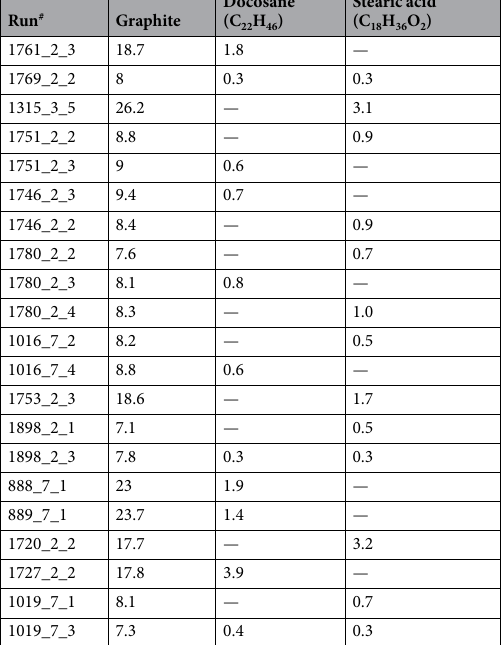
Table 1. Starting compositions (mg). Microscopic amounts of nitrogen in the capsules came from